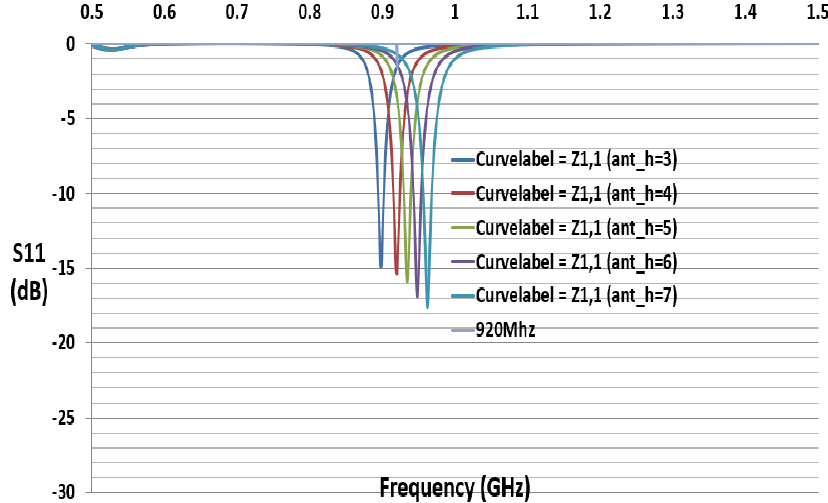
Figure 6 . Simulated S11 results with variation of parameter ant_h (mm). Figure 6. Simulated S11 results with variation of parameter ant_h